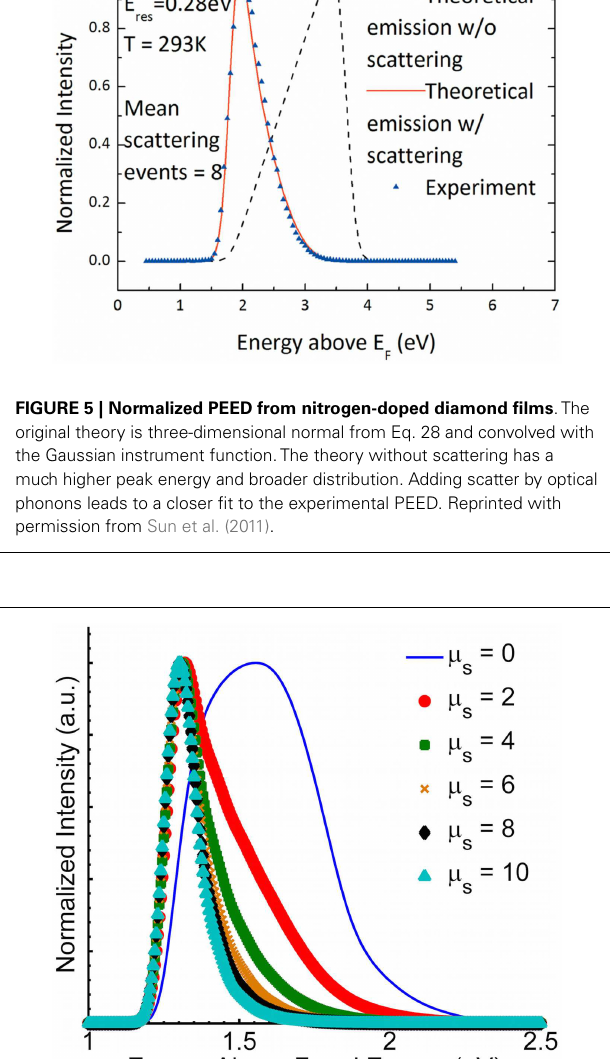
Figure 7 is of two-dimensional and three-dimensional thermionic fits to an experimental TEED for thermionic emission from graphitic petals at 1123 K (McCarthy, 2013). The estimated para- meters from data fitting are provided in Table 1 . A distinct nar- rowing of the distribution occurs for the same parameter values for two-dimensional emission compared to three-dimensional in the left plot in Figure 7 . The narrowing is not apparent in the right plot as the fit allows for T to change, and an increased tempera- ture relative to the three-dimensional fit causes a broadening of the distribution that offsets any narrowing caused by reduced dimen- sionality. A slight lowering of the peak energy is also apparent.